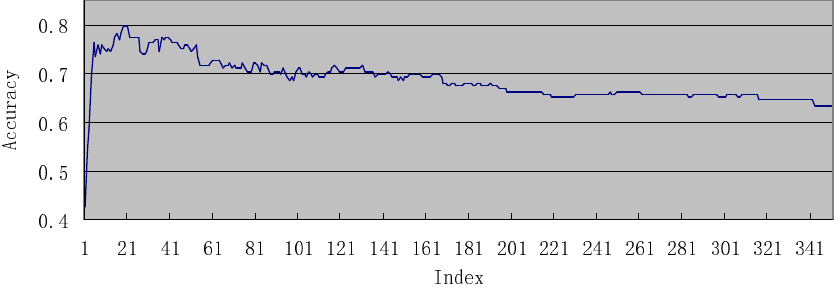
Figure 2. The IFS (incremental feature selection) curve. See the text in Section 3.2 for further explanation.